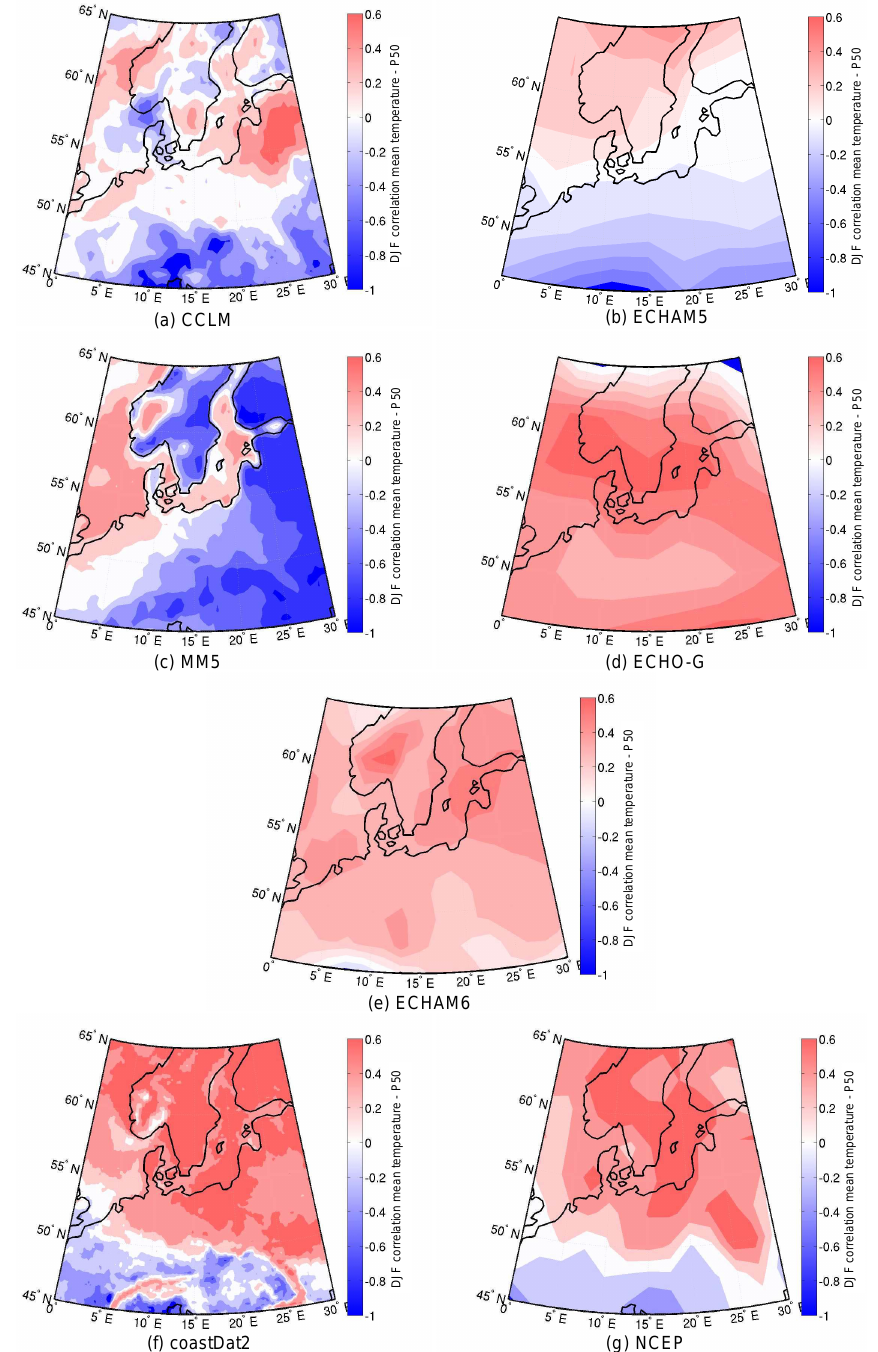
Figure 3. Correlation between field mean temperature and 50th percentile of wind speed for seven different data sets: (a) CCLM (1655– 1999 AD), (b) ECHAM5 (850–2005 AD), (c) MM5 (1001–1990 AD), (d) ECHO-G (1001–1990 AD), (e) ECHAM6 (850–2005 AD), (f) coastDat2 (1948–2012 AD), (g) NCEP (1948–2012